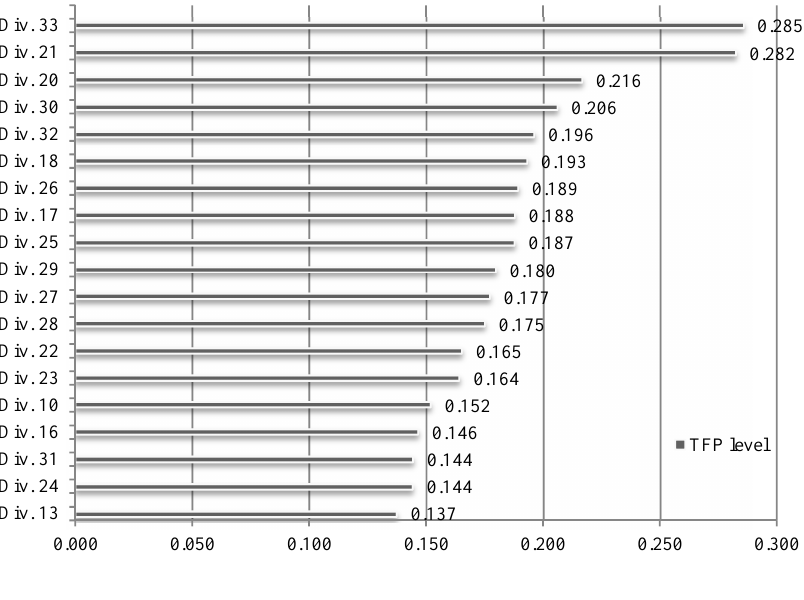
Figure 2. TFP level in the analysed manufacturing divisions (average value for